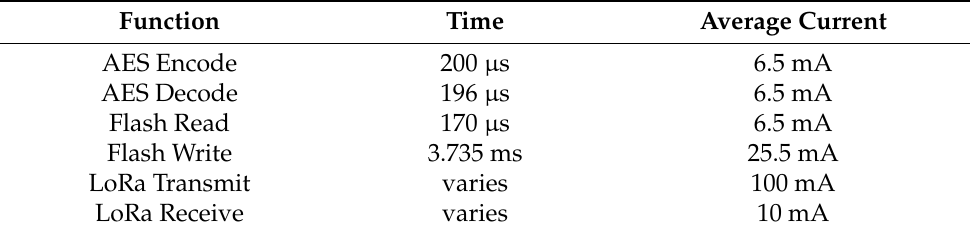
Figure 7. Timing characterization for Advanced Encryption Standard (AES) and flash read and writes. Table 3. The settings used for modeling the firmware update